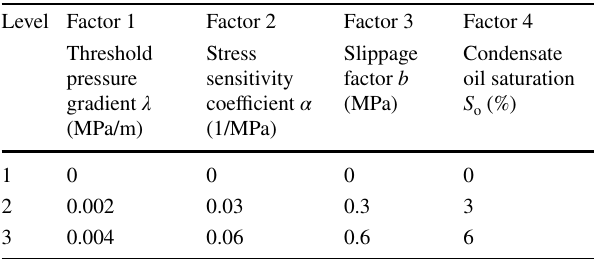
Table 4 Level table of influencing factors for productivity of a low- permeability condensate gas well